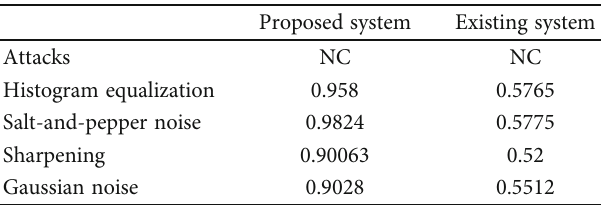
Table 5: Comparison results of the proposed system against an existing study [65].